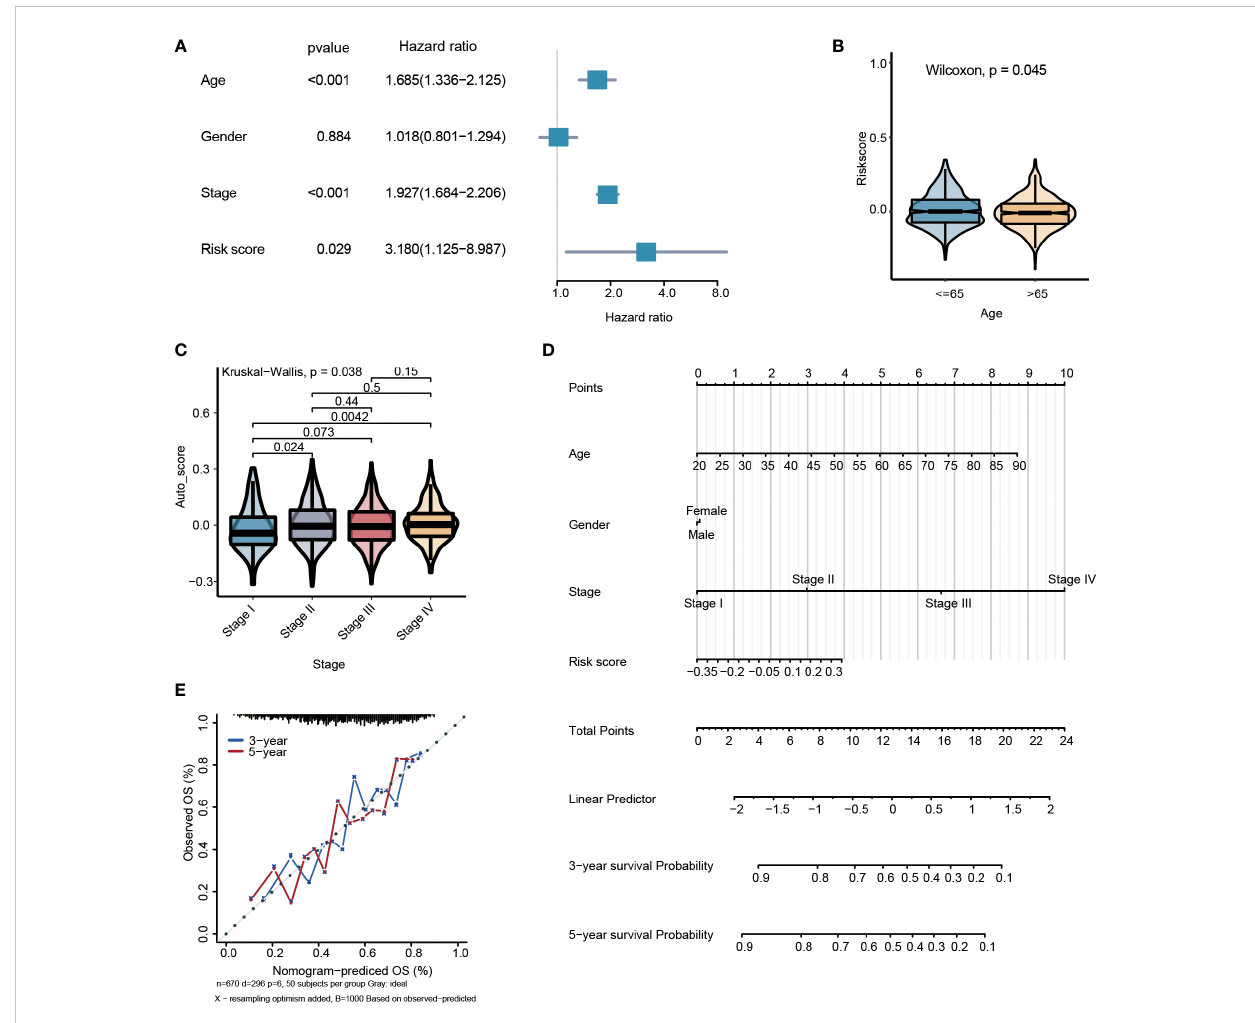
FIGURE 6 Multivariate survival analysis and nomogram construction for predicting overall survival combining the risk signature with clinicopathological characteristics. (A) Forest plot of hazard ratios from the multivariable Cox proportional hazard regression model suggests that risk score is an independent risk factor. (B) Box plot of risk score levels grouped by age (P<0.05). (C) Box plot of risk score levels grouped by stage (P<0.05). (D) Nomogram predicting overall survival probability for GC patients. (E) Calibration of the nomogram for 3- and